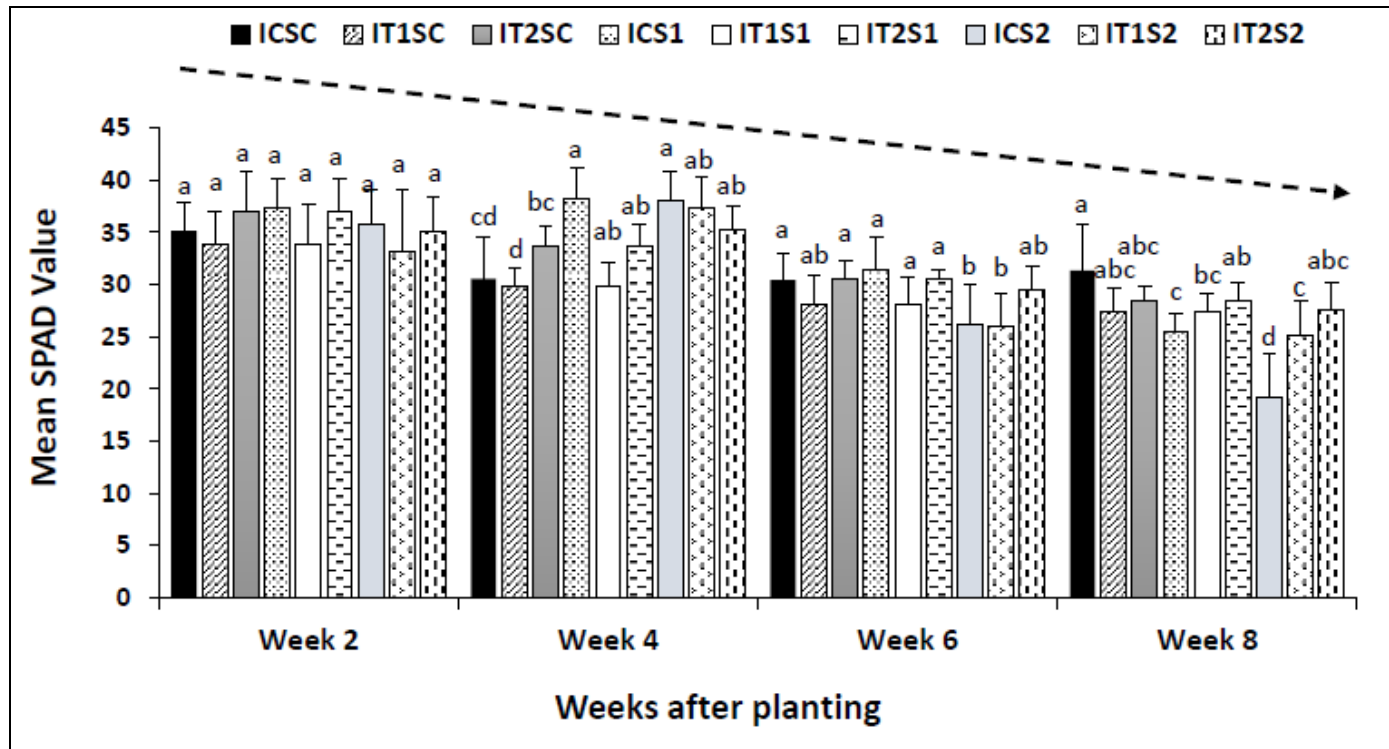
Figure 4. Mean comparison of soil plant analytical development (SPAD) meter reading of snap bean leaves at di ff erent time after planting (2, 4, 6, and 8 weeks) for nine treatments. Treatments consist of inoculation type (IC = No inoculation, IT1 = AMF, IT2 = Rhizobium + AMF) and salinity levels (SC = Salinity control 0.6 dS m − 1 EC, S1 = 1.0 dS m − 1 EC, and S2 = 2.0 dS m − 1 EC). Salinity was applied 26 days after planting (DAP). Error bars represents standard deviations of mean values. p < 0.05, same letters indicate no statistical di ff erence among the treatments while di ff erent letters indicates treatments have significantly di ff erence. We used 10 plants ( n = 10) for each treatment.